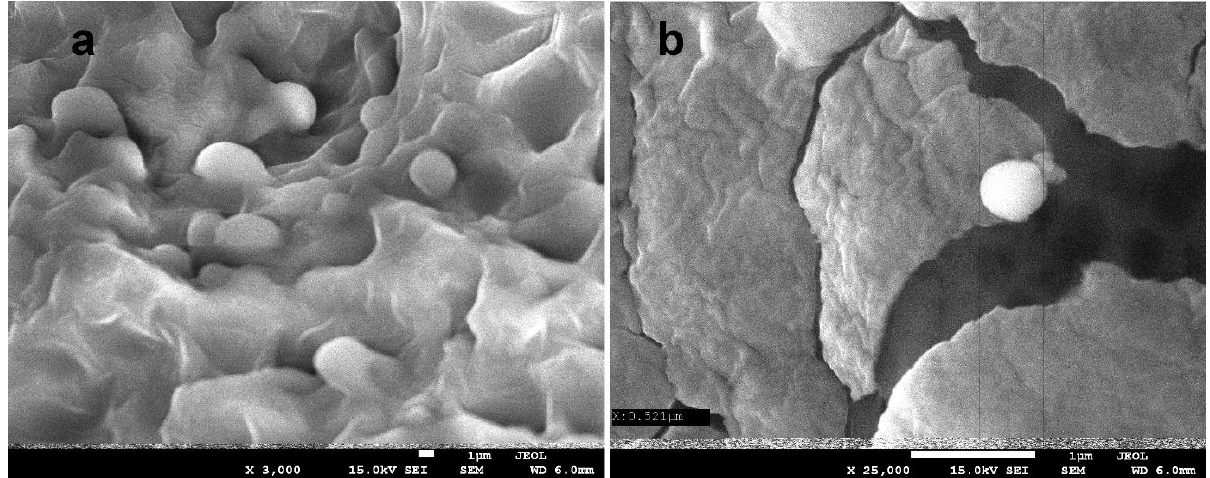
Figure 8. A SEM image of the Cur-2 composite at an ×3000 ( a ) and ×25,000 ( b ) magnification. The surface free energy was determined by the Owens–Wendt method [28,31]. The